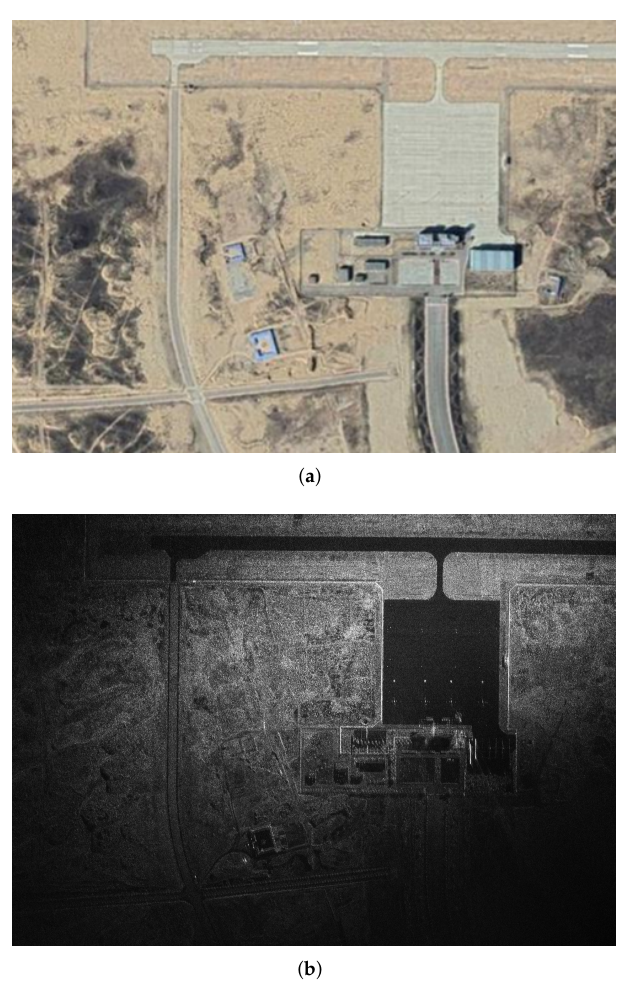
Figure 15. Imaging results of the WFBP algorithm. ( a ) Optical image; ( b ) imaging results of real experiment data by the WFBP